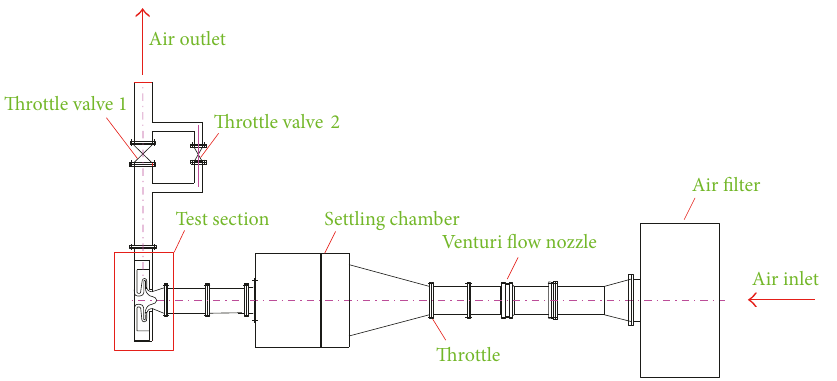
Figure 1: Schematic layout of the test